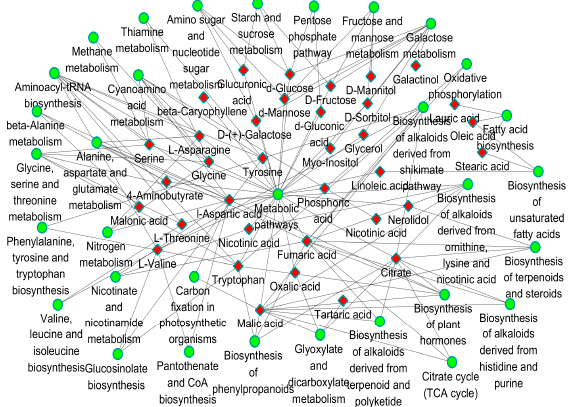
Figure 4. The metabolite-to-metabolite networks involved in the primary pathways of ginseng response to development regulation. Green circles, metabolite pathways; Red diamonds , metabolites.